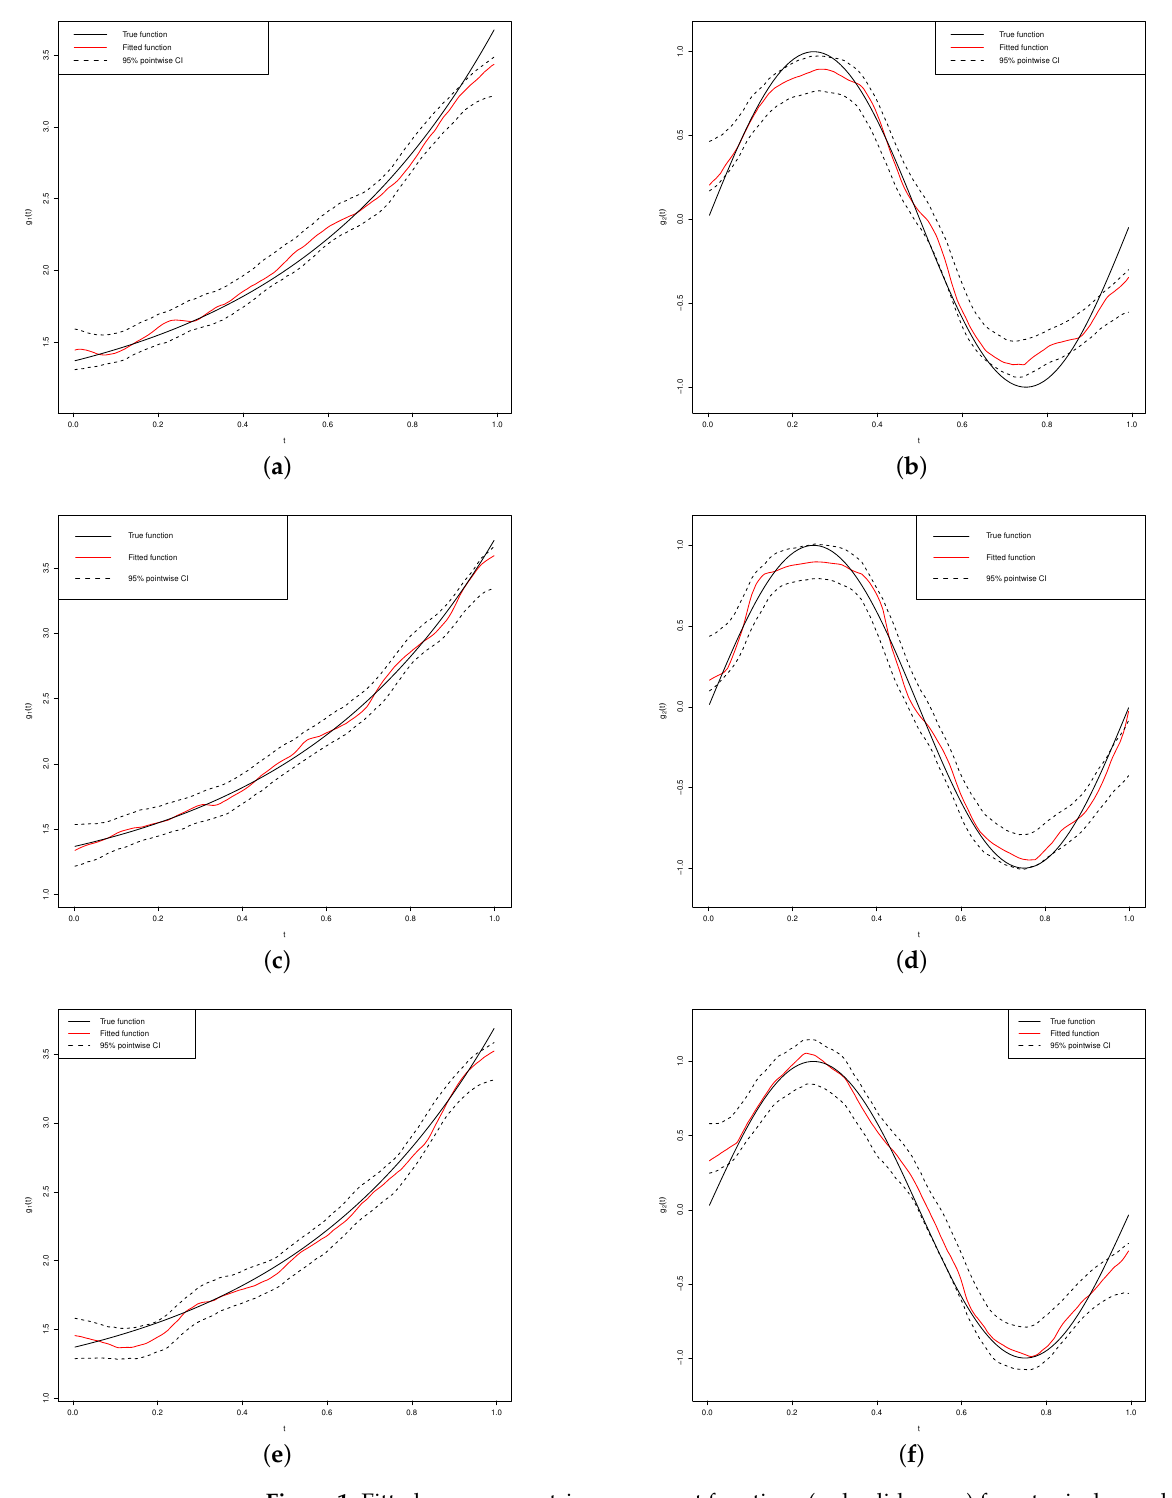
Figure 1. Fitted non-parametric component functions (red solid curve) for a typical sample of size n = 400 based on the ( a , b ) OB-PL-EM algorithm, ( c , d ) PL-p-EM algorithm and ( e , f ) PL-EM algorithm. The black solid curve gives the true component function. The dotted lines give the 95% bootstrap confidence